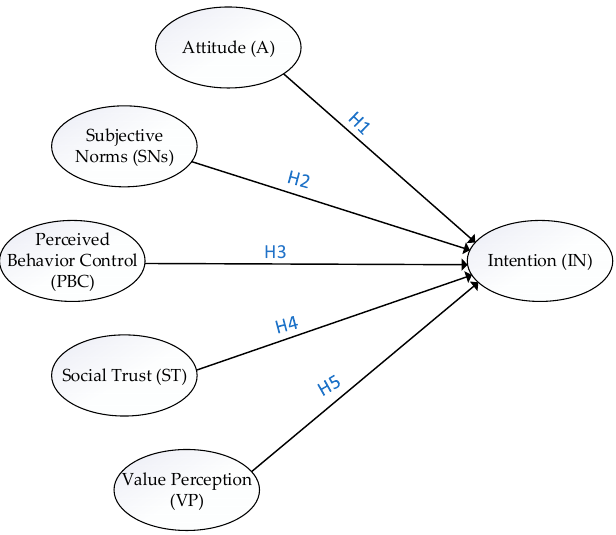
Figure 1. Driving factors of the straw recycling intentions of farmers.